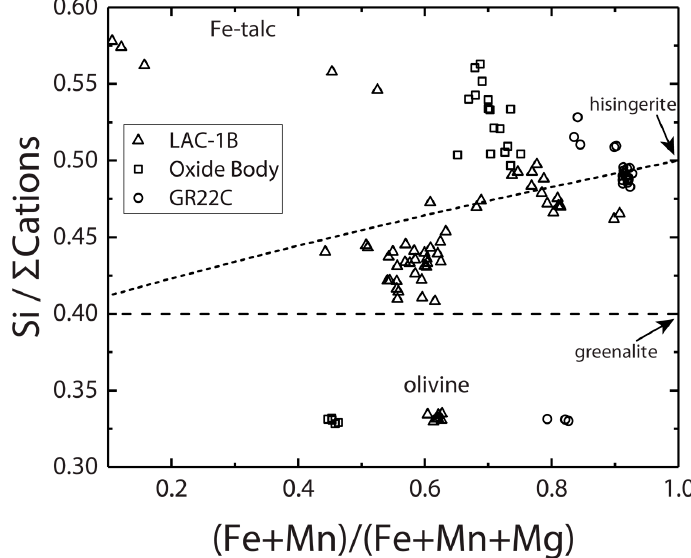
Figure 3. Formula proportions from electron microprobe spot analyses of phyllosilicate and igneous olivine in three Laramie Anorthosite Complex metaperidotites and gabbros. Dashed lines from Figure 1.